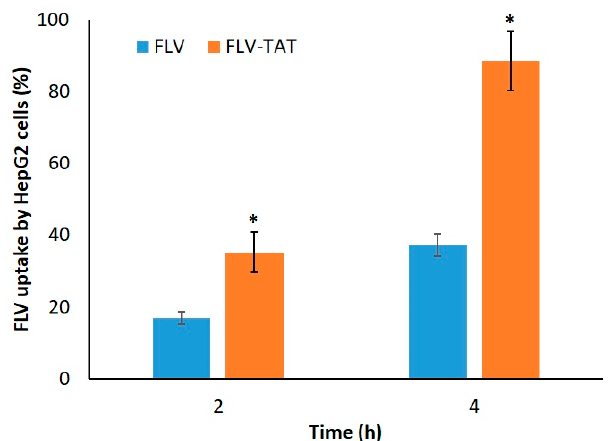
Figure 4. Percentage cellular uptake of FLV after 2 and 4 h for raw FLV and optimized FLV–TAT. Data represent mean of six independent replicates ± SD. * Significantly different ( p < 0.05) relative to corresponding FLV, as determined by Student’s t -test.